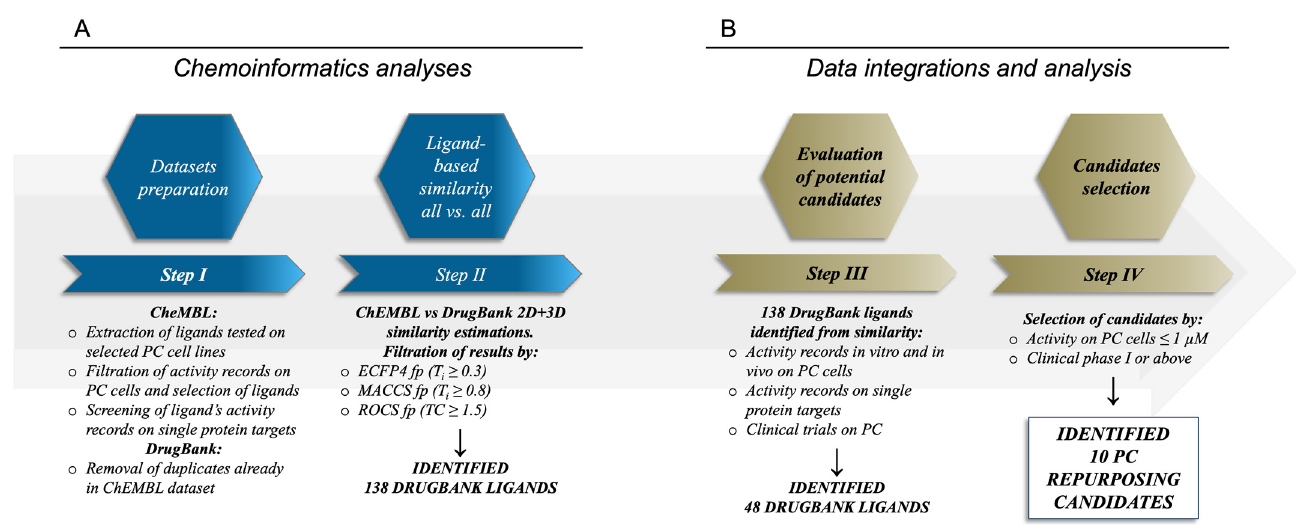
Figure 1. Workflow adopted for the identification of potential drug repurposing candidates for PC. Panel ( A ) describes the ligand-based procedure, while panel ( B ) contains the data integration and analysis procedure for the selection of the repurposing candidates.